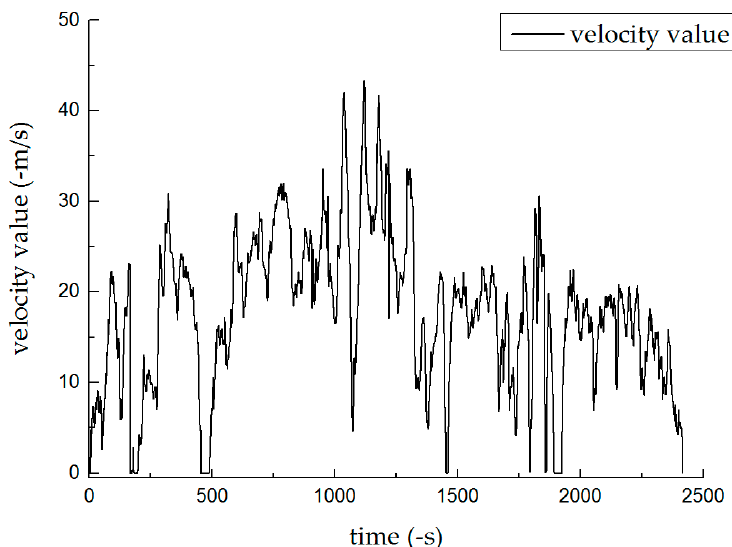
Figure 8. Experiment 2: Vehicle trajectory.